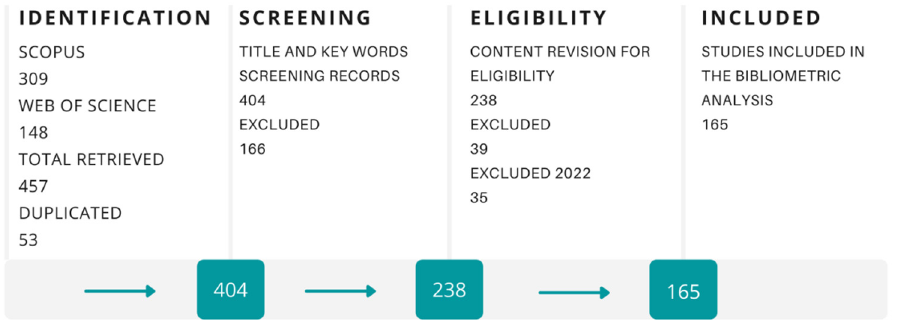
Figure 10. Literature review methodology for recycled polymers used in FDM.